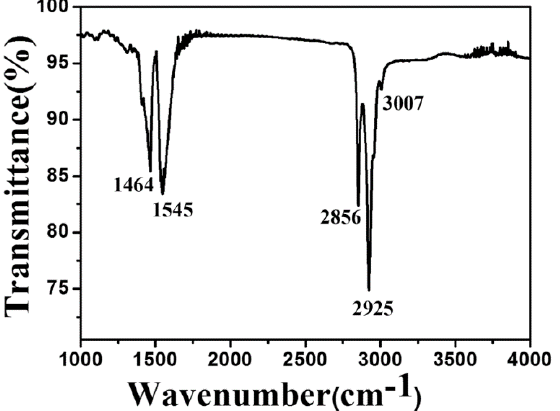
Figure 7. The FTIR spectrum of the oleic-acid-coated KMnF 3 :18%Yb 3+ ,1%Er 3+ @KMnF 3 :2%Yb 3+ NPs.